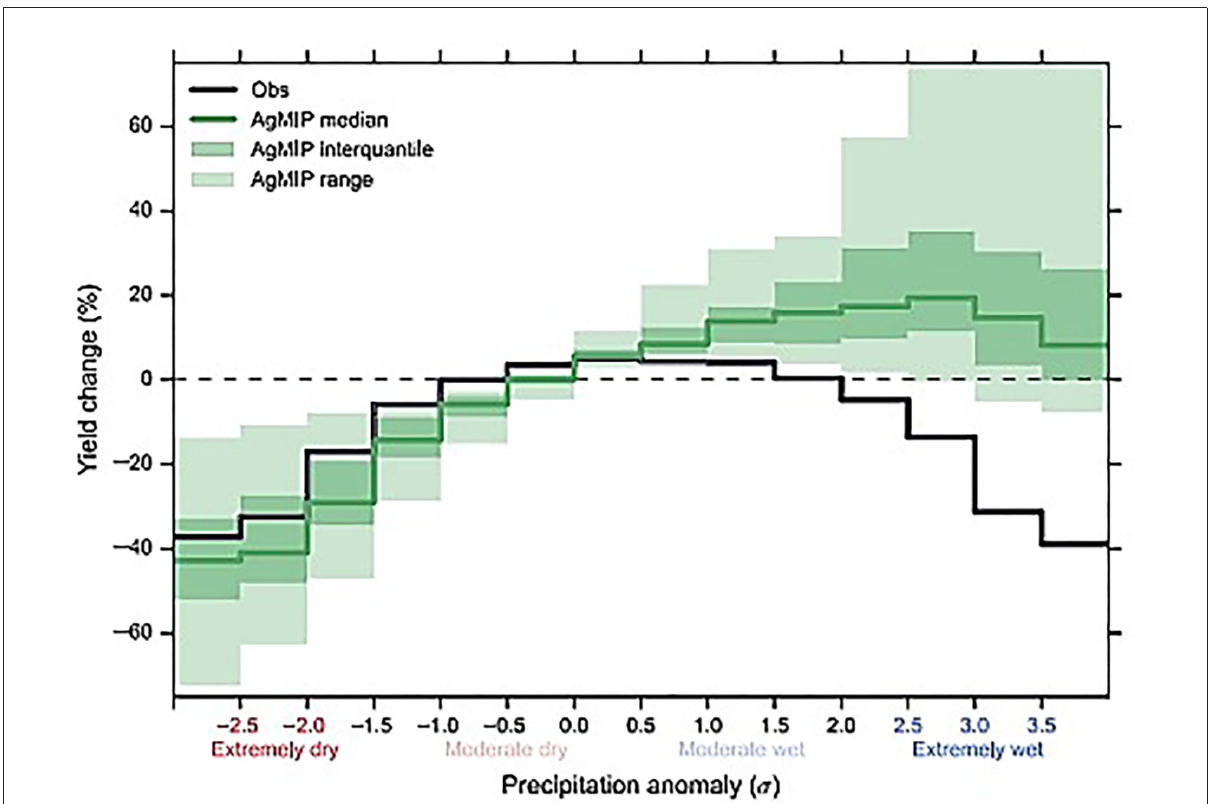
TABLE 2 Variables of maize growth and yield under water stress (HighIRR and LowIRR) during different maize growth stages and FullIRR during the maize growing season from 2013 to 2016. LAI max Canopy height Biomass Unit Kernel Kernel per Yield (cm) (kg/ha) weight (g) spike (kg/ha) FullIRR 3.4 a 216 17,353 a 0.277 a 544 a 7,768 a HighIRR SDS 2.5 cd 195 10,664 bc 0.221 cd 433 c 4,945 d JTS 3.0 ab 193 12,591 bc 0.245 bc 462 b 5,588 c HDS 3.1 ab 211 14,276 ab 0.255 ab 458 b 6,212 b GPS 3.0 ab 205 14,193 ab 0.238 bc 485 a 5,822 b LowIRR SDS 2.1 d 172 8,678 d 0.205 d 368 d 3,573 f JTS 2.7 bc 162 9,145 cd 0.224 bcd 366 d 3,868 e HDS 2.7 bc 184 10,071 c 0.240 b 374 cd 4,455 de GPS 2.7 bc 185 10,711 bc 0.221 bcd 456 b 4,676